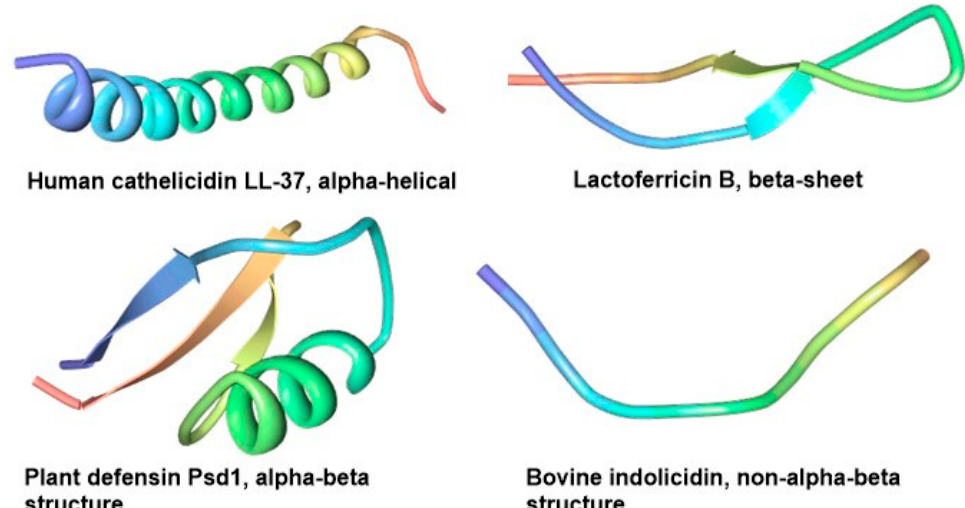
Figure 1. 3D structures of selected AMPs, depicting four structural families based secondary structures found in the compound: alpha, beta, alphabeta and non-alphabeta. Structures were edited with protein workshop using the solution NMR structural data for Human cathelicidin LL-37 (PDB: 2K6O), lactoferricin B (PDB: 1LFC), plant defensin Psd1 (PDB: 1JKZ) and bovine indolicidin (PDB: 1G89).